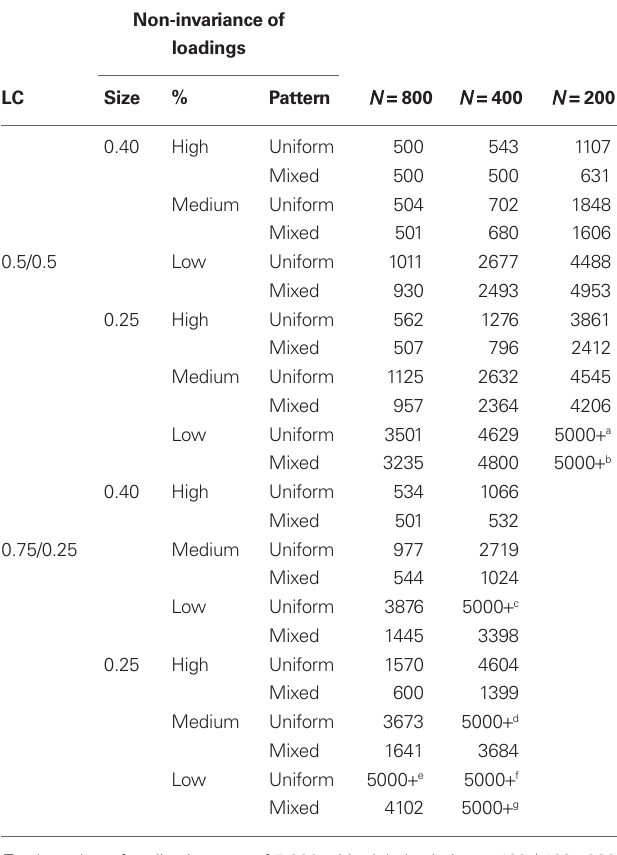
Table 2 | Number of replications out of 5,000 needed to achieve 500 global